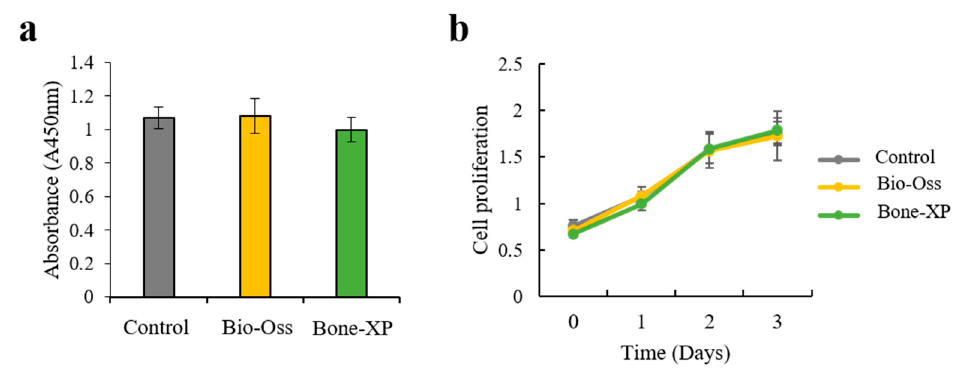
Figure 5. ( a ) Cell viability and ( b ) proliferation of extracts on human mesenchymal stem cells (hMSCs).